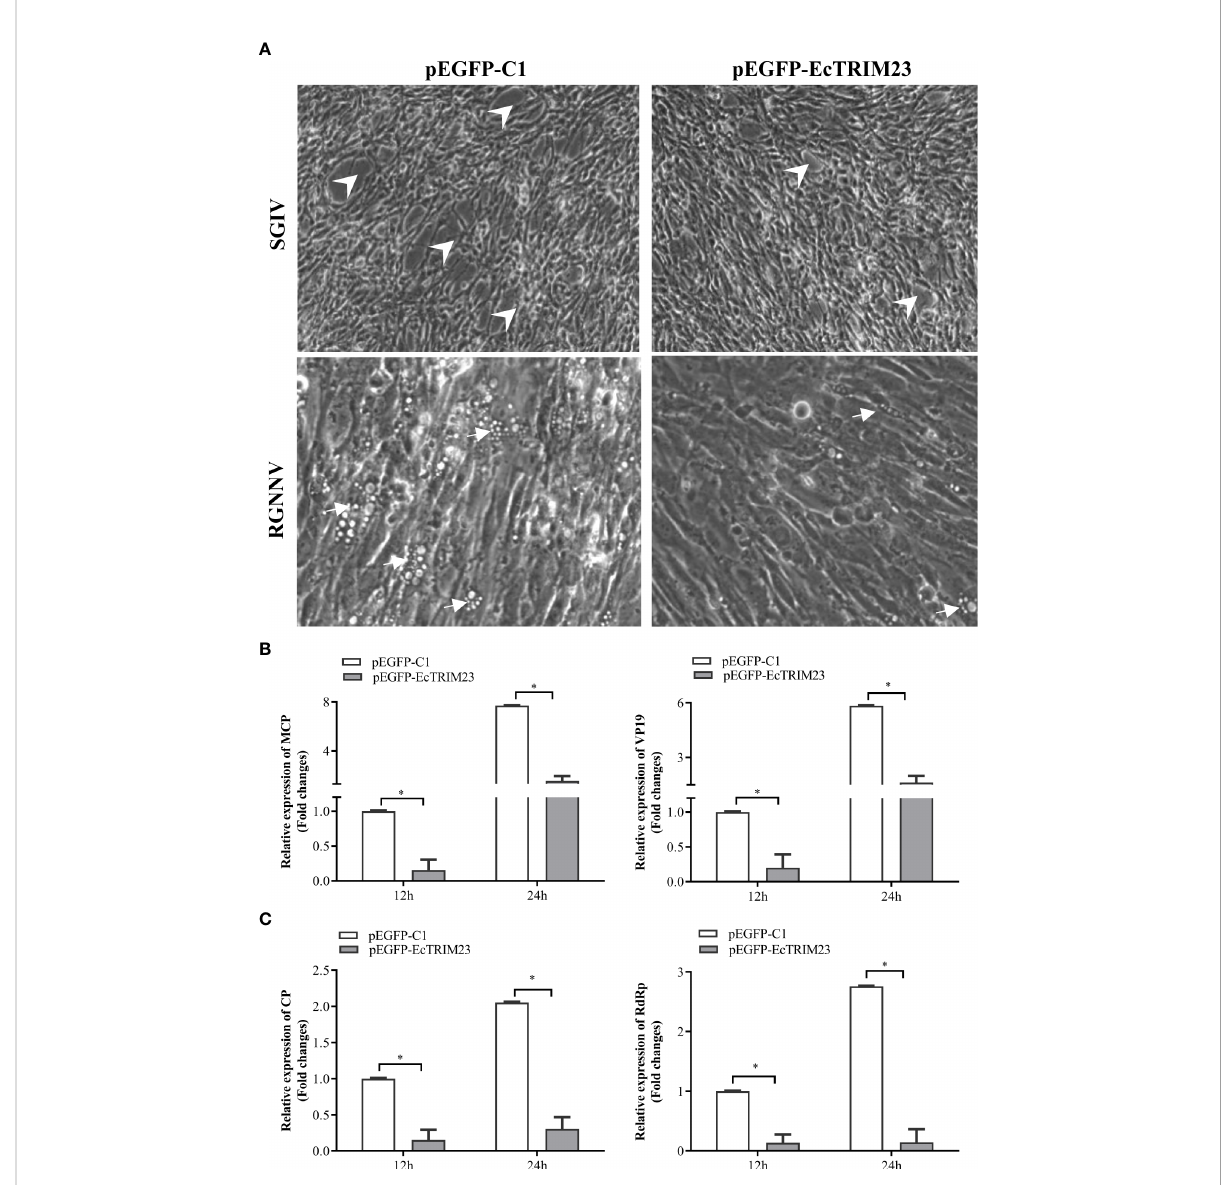
FIGURE 3 The effects of EcTRIM23 on SGIV and RGNNV replication. (A) EcTRIM23 overexpression weakened the severity of virus-induced CPE in GS cells. The white arrows indicated the vacuoles induced by RGNNV infection and the arrowheads showed the rounding and aggregated cells induced by SGIV infection. (B) The transcription of SGIV MCP and VP19 in infected EcTRIM23-overexpressing cells. (C) The transcription of RGNNV CP and RdRp in infected EcTRIM23-overexpressing cells. The transfected cells were infected with SGIV or RGNNV, and harvested at 12 h.p.i. and 24 h.p.i. to determine the mRNA expression levels of viral genes by qPCR. * p <